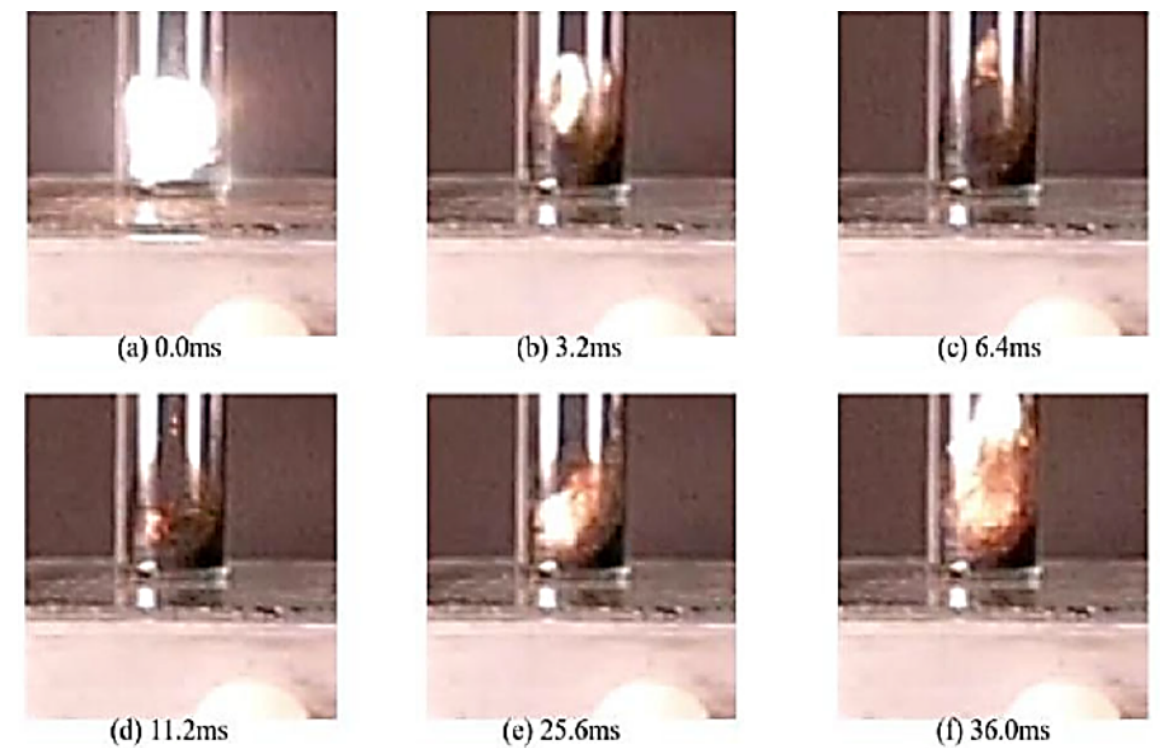
Figure 1: High-speed camera photos, provided by the authors, of the laser initiation of APSWCNT/ferrocene (1:2, 10 mg total) displaying the initial ignition (a-d) followed by a secondary ignition (e–f) when the ferrocene is initiated and oxidizes. Time shown refers to the amount of time passed since the light source was triggered